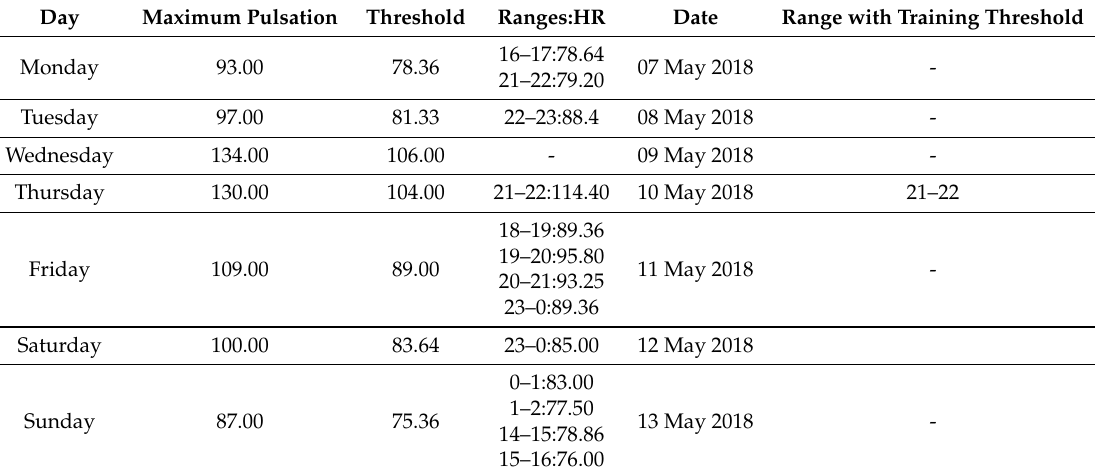
Table 3. Training week 3 from 7 to 13 May.